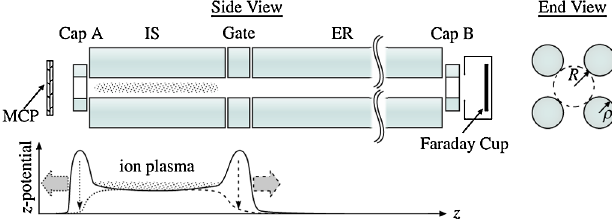
FIG. 1. (Color) S-POD setup for resonance experiments. An ion plasma is generated and confined in the ion source (IS) region using electron impact ionization of a neutral gas. After shutting down the electron beam for ionization and evolving the plasma for a limited number of rf focusing periods, the plasma is extracted for measurements by dropping the bias potential on either the gate or end cap